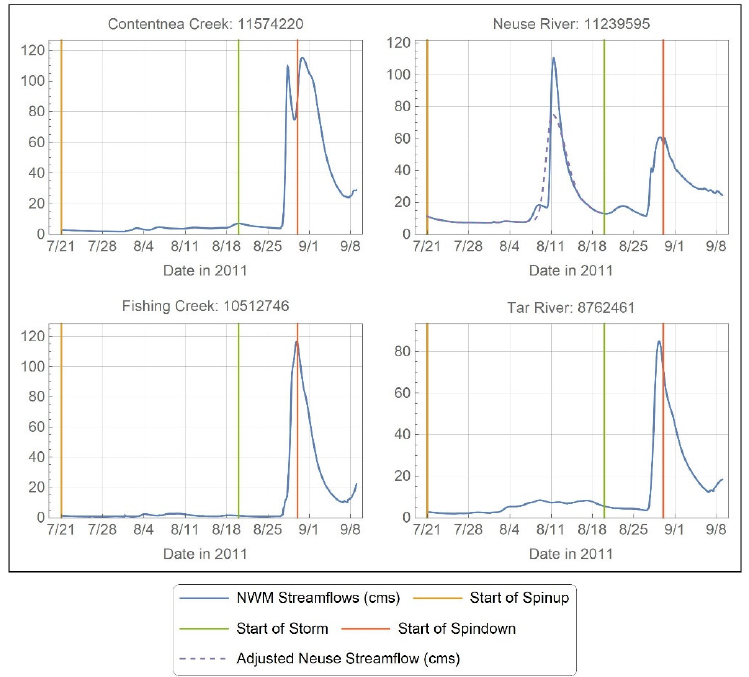
Figure 10. National Water Model input streamflows (cms) for the four main features in the study region during the simulation timeframe: Contentnea Creek, Neuse River, Fishing Creek and Tar River. The numbers following the names correspond with the NWM v1.2 feature identifications.